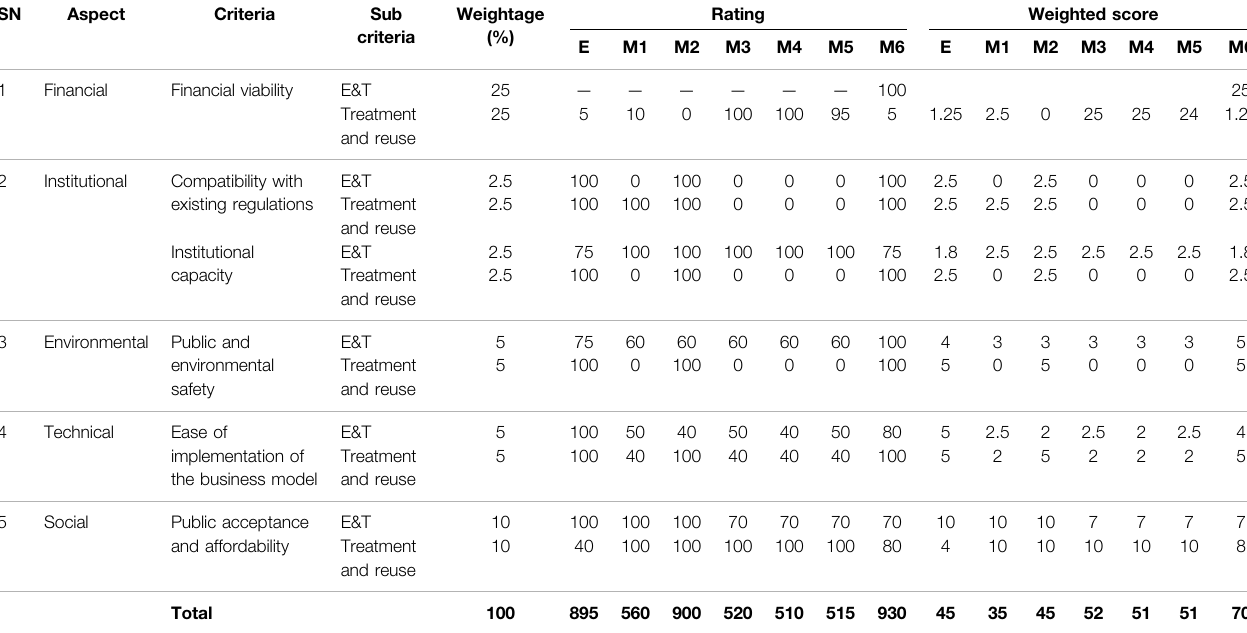
TABLE 8 | Multi-criteria analysis of FFMs (FIETS). Bold values are the total (sum) of values of the column i.e. weightage of each aspect totaling to 100%. SN